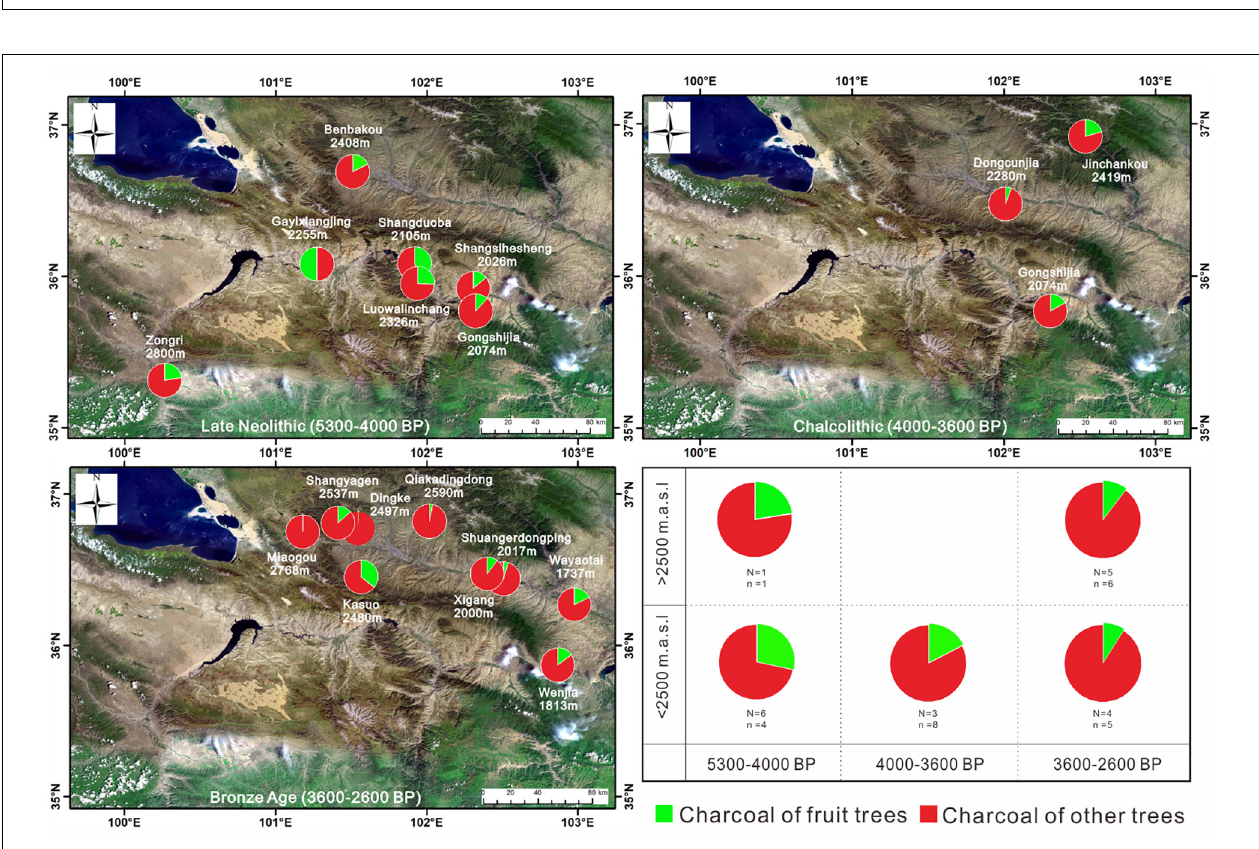
FIGURE 5 | Spatiotemporal comparisons of woody assemblages (including the proportions of fruit trees and other woody plants) from the investigated sites in the NETP dated to the periods 5,300–4,000 BP, 4,000–3,600 BP, and 3,600–2,600 BP ( n is the number of fruit-tree taxa identified; N is the number of investigated sites).